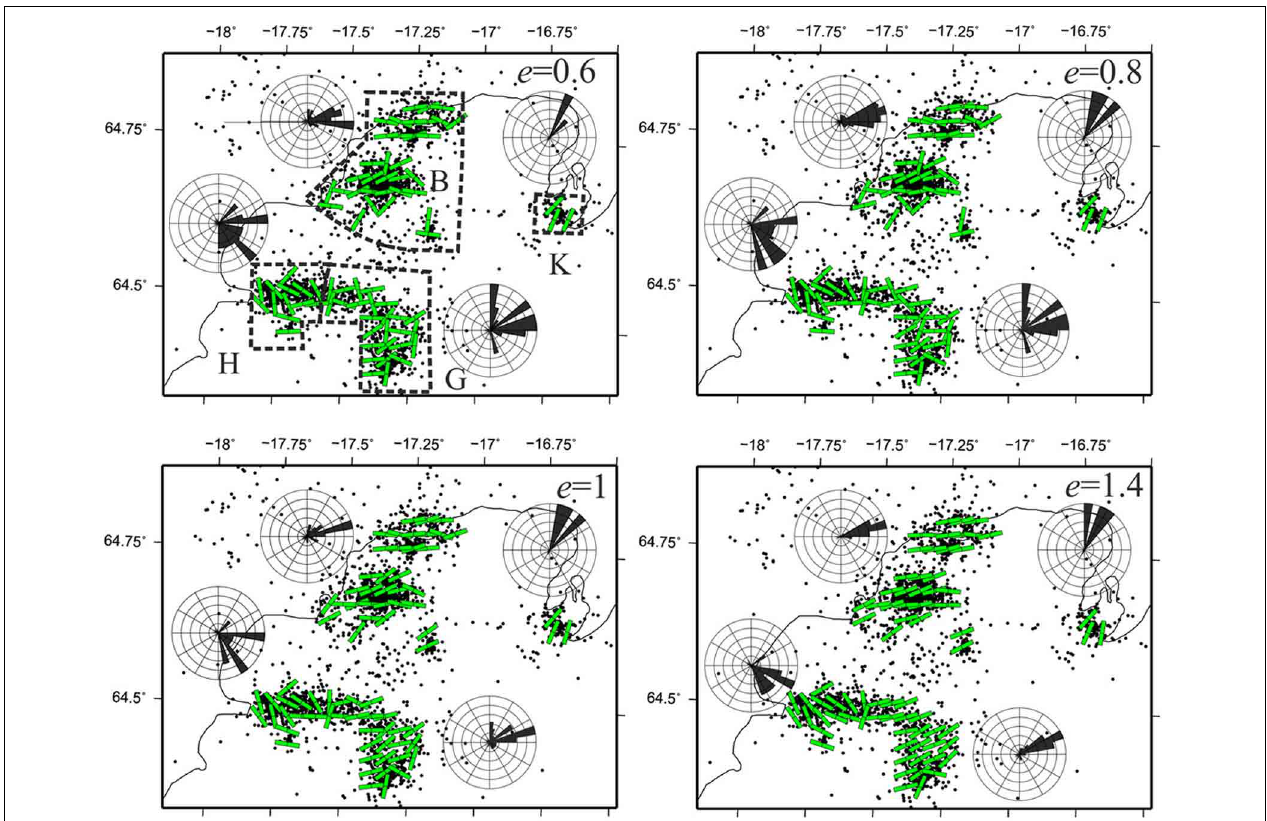
FIGURE 6 | (cid:3) σ hmin maps for the different damped stress fields. The inset rose diagrams depict the direction of (cid:4) σ hmin in 10 ◦ bins for each volcano denoted by the capital letter and delimited by the dashed black line (only showed on the stress field for e = 0 . 6). Same background as for Figure 3